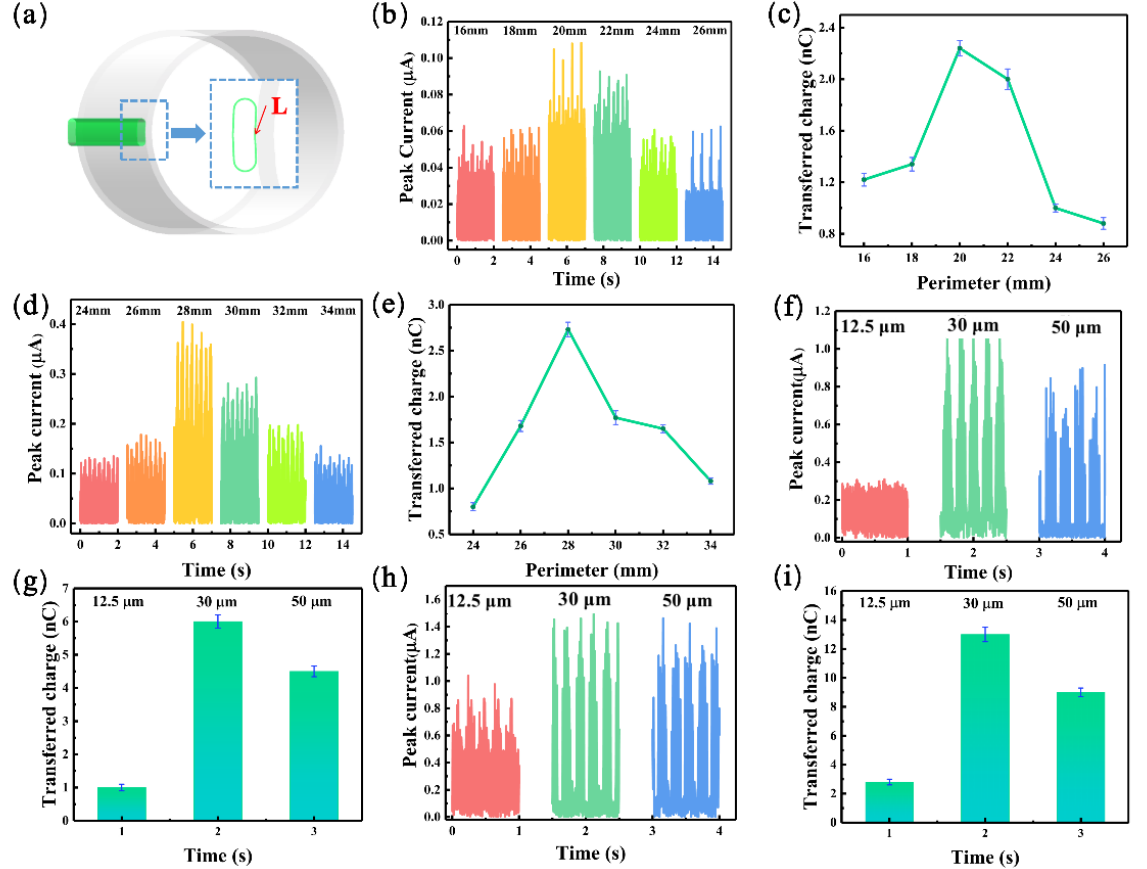
Figure 2. The effect of different parameters of the arched FEP film on the electrical output performance of MC - TENG. ( a ) Adjustment of the perimeter and thickness of the films. ( b – e ) Variation in the peak current and transferred charge for different perimeters of FEP arches in each TENG unit. ( f – i ) The peak current and the amount of transferred charge for different thicknesses of FEP arches in each TENG unit.